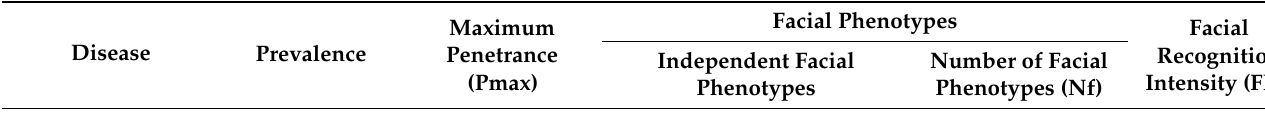
Table 1. Assessment of facial recognition intensity (FRI) of diseases in the eligible